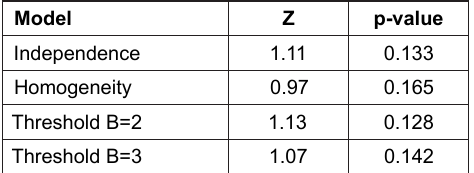
Table 6. Tests for randomness of collared caribou across groups for the Bluenose-East 2010 survey.